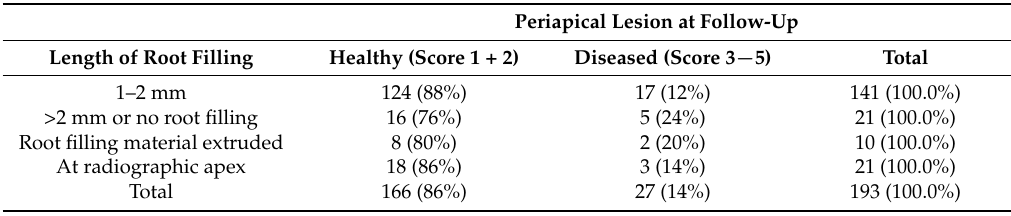
Table 3. Relationship between the length of root filling and the periapical lesion (PAI) at